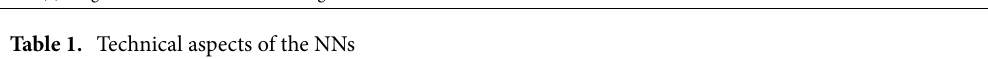
the results obtained while training the seven individual subnets corresponding to the position values considered when constructing the trails in Fig. 2. It can be seen that learning occurs very quickly (under 100 iterations) for the position marked with a green circle (away from the well): the relative loss function decreases sharply to zero in a few iterations after which it has only a faint variation. The learning also goes fast for the position marked with